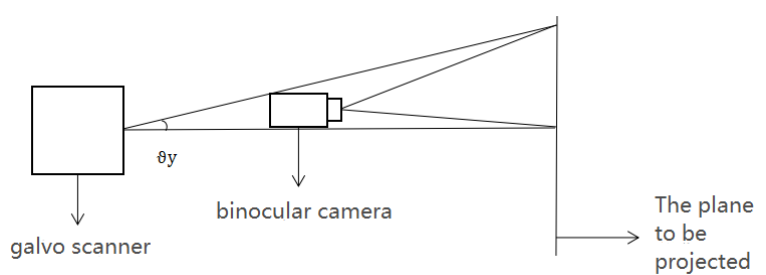
Figure 4. Mapping of camera and galvanometer coordinates.